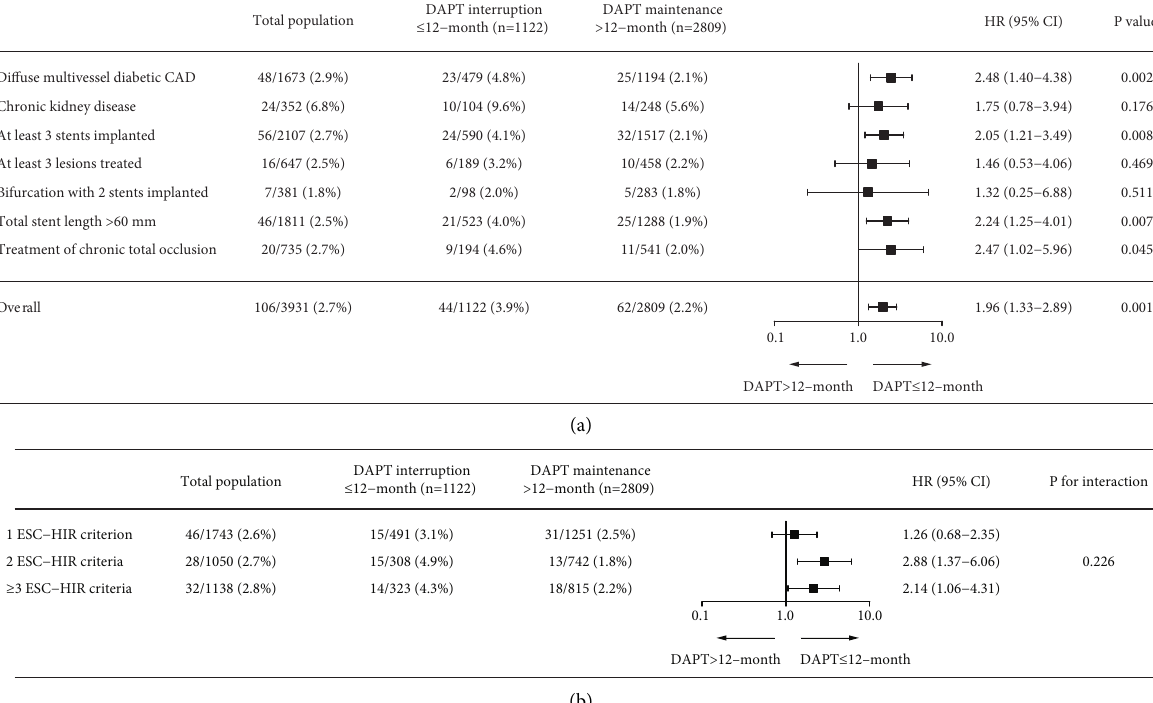
Figure 5: Comparison of long-term risk of primary ischemic endpoint between DAPT interruption ≤ 12 months and DAPT main- tenance > 12 months according to subgroups. The cumulative incidence and hazard ratio with 95% confidence interval of primary efficacy endpoint are presented between DAPT > 12 months and DAPT ≤ 12 months according to the components of the ESC stent-driven high ischemic risk definition (a) and number of ESC stent-driven high ischemic risk criteria fulfilled (b). CAD � coronary artery disease; HIR � high ischemic risk; and other abbreviations are as in Figure